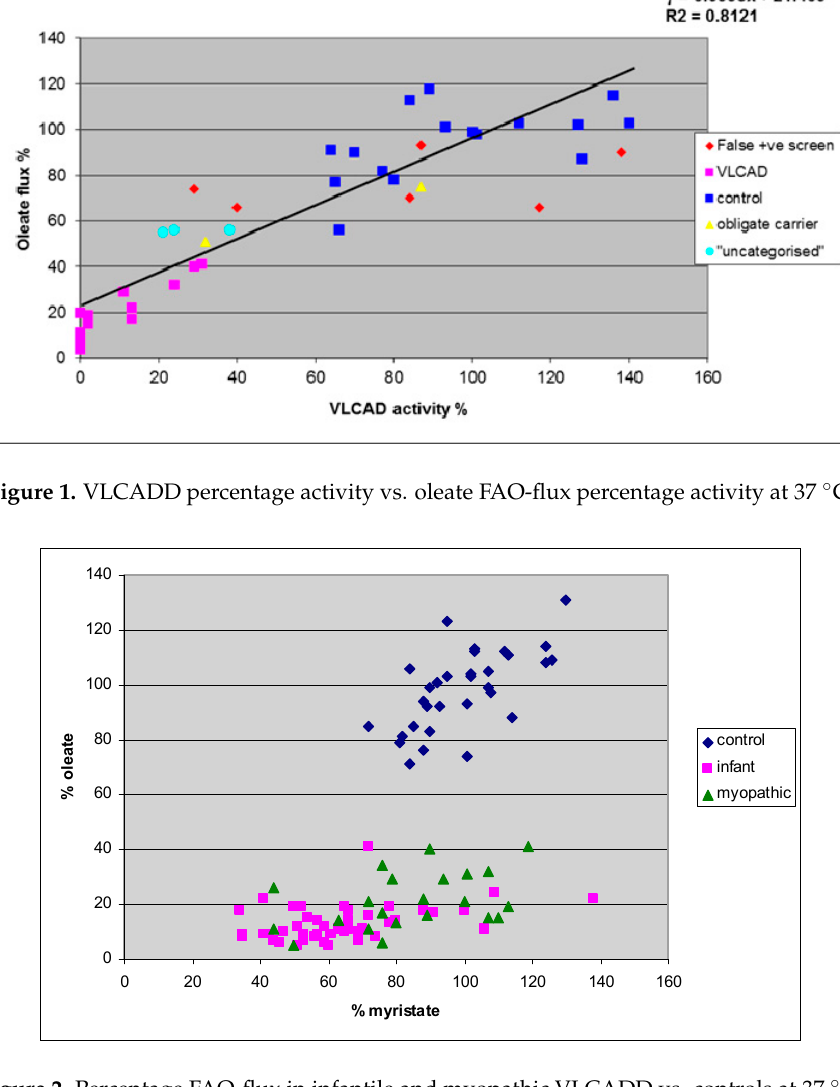
Figure 2. Percentage FAO-flux in infantile and myopathic VLCADD vs. controls at 37 °C. Results of flux assays at 37 ◦ C show clear separation of all VLCADD cell lines from controls by plotting percentage oleate FAO-flux against percentage myristate FAO-flux (Figure 2). A degree of separation between infantile and myopathic phenotypes is clearly discernible, although there is some overlap between the two groups. Plotting fibroblast FAO-flux results obtained at 41 °C after growing and assaying 19 VLCADD cell lines that exhibited high residual FAO-flux >20% at 37 °C is shown in Figure 3. Control cell lines were also grown and assayed at 41 °C. The results of the VLCADD cell lines with low FAO-flux at 37 °C are also plotted to demonstrate the merging of the two groups following temperature stress of 19 high residual FAO-flux cell lines. This results in all VLCADD cell lines having an oleate FAO-flux of ≤ 30% with 60/69 cell lines giving activity of <20% (Figure 3).